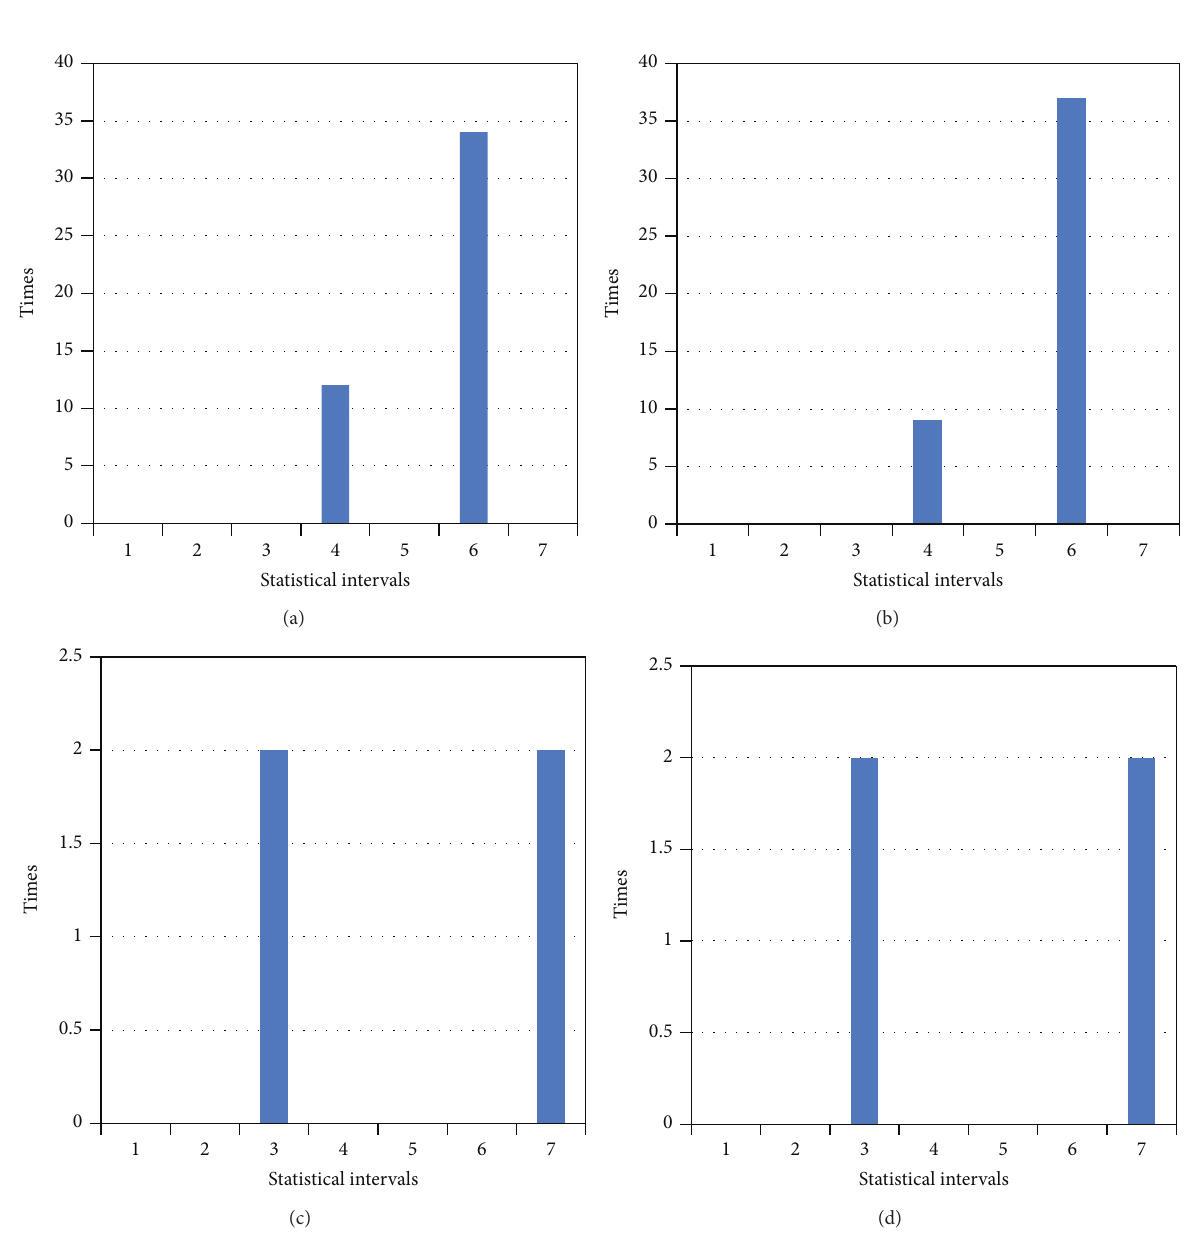
Figure 13: Statistical histogram information of TCP and UDP port number: (a) TCP source port number, (b) TCP destination port number, (c) UDP source port number, and (d) UDP destination port